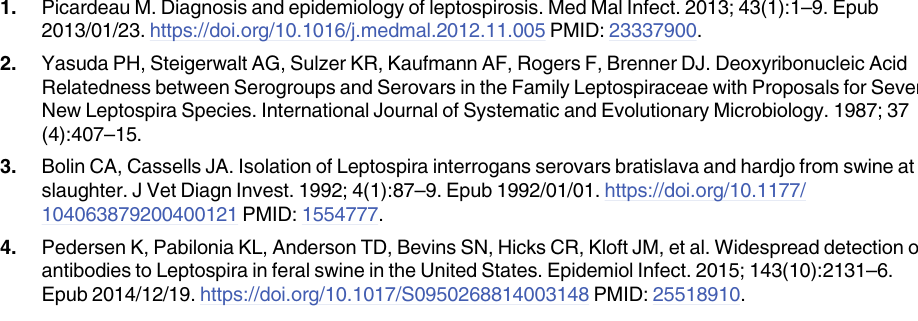
S1 Table. Pathogenic Leptospira PCR